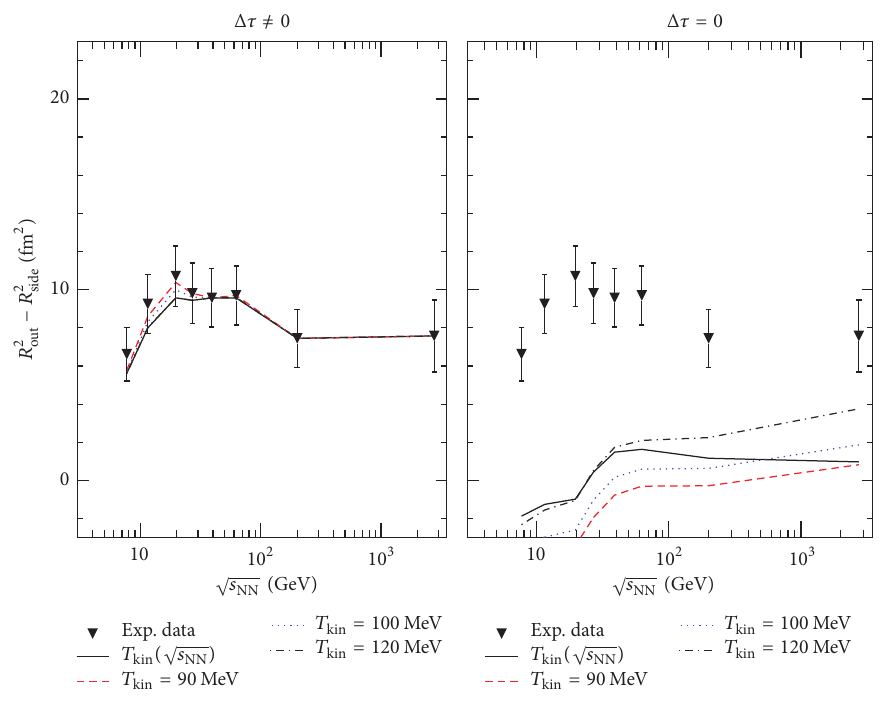
− 𝑅 2 . Experiment data is taken from out side